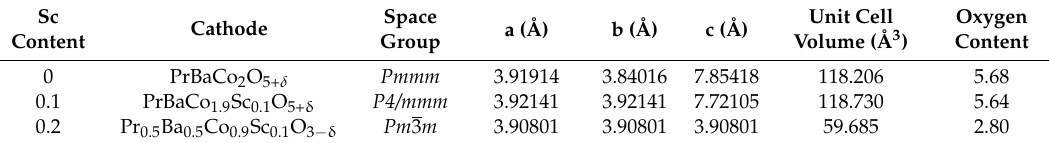
Figure 1. ( a ) X-ray diffraction (XRD) patterns of PrBaCo 2 O 5+δ (PBCO), PrBaCo 1.9 Sc 0.1 O 5+δ (PBCSc), and Pr 0.5 Ba 0.5 Co 0.9 Sc 0.1 O 3−δ (SP-PBCSc). ( b ) The chemical compatibility between the cathode materials and Ce 0.9 Gd 0.1 O 2− δ (GDC). Difference between the observed and calculated XRD profile of ( c ) PBCO, ( d ) PBCSc and ( e ) that of SP-PBCSc. Table 1. Space group and lattice parameters of PBCO, PBCSc and SP-PBCSc.